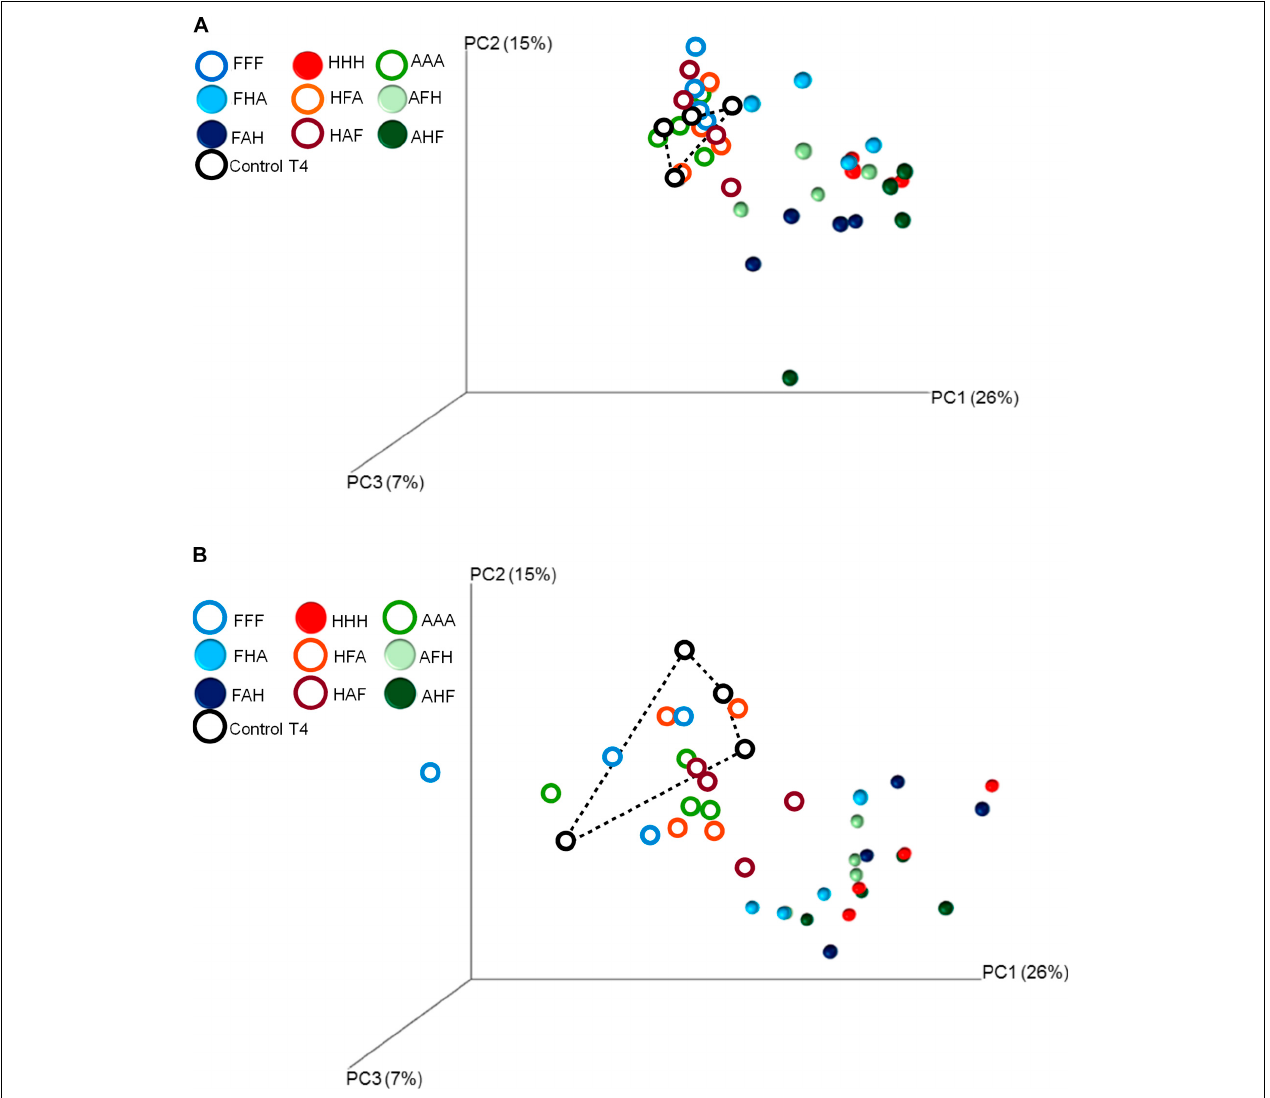
FIGURE 5 | Principal Coordinates Analyses of the weighted UniFrac distance matrix representing differences in community structure between control and treated microcosms at T 3 (A) and T 4 (B) . Different colors correspond to the different treatments and to control microcosms. Closed symbols are used to show treatments that are significantly different from the control microcosms